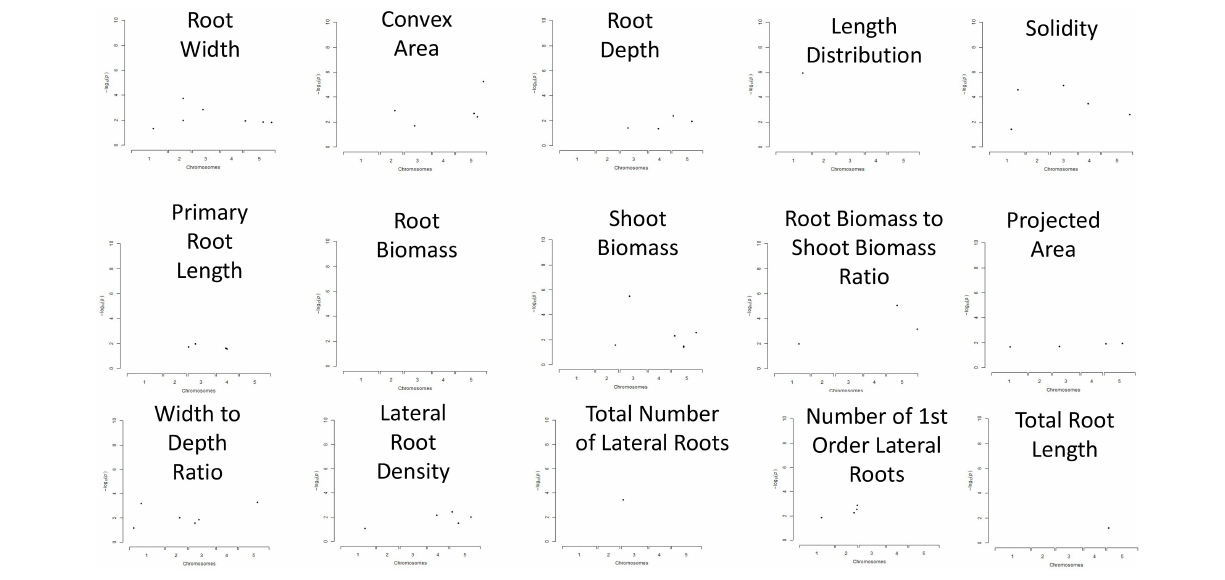
FIGURE 8 | Manhattan plot representation of associated single nucleotide polymorphisms (SNPs) detected for each of 15 RSA traits, plotted on the x -axis, based on their genomic position. Loci that are close to each other are averaged as one point in the scheme, for simplified visualization.